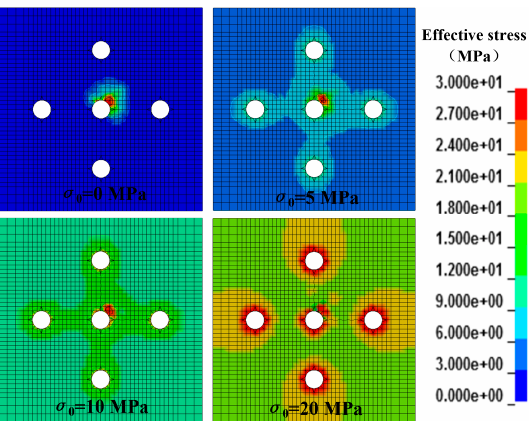
Figure 21. Effective stress contours of the rocks containing five holes under different confining pressure.